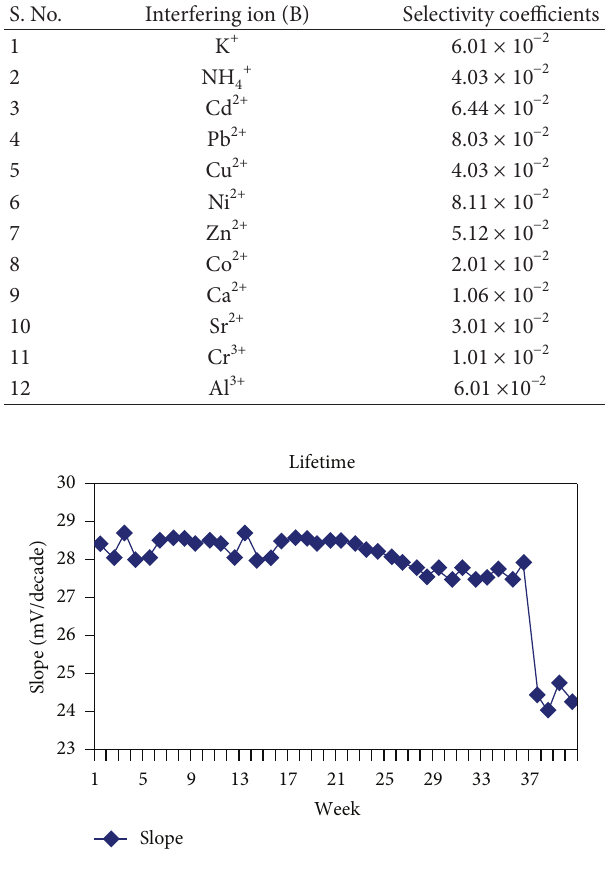
F 5: Lifetime of the proposed sensor.